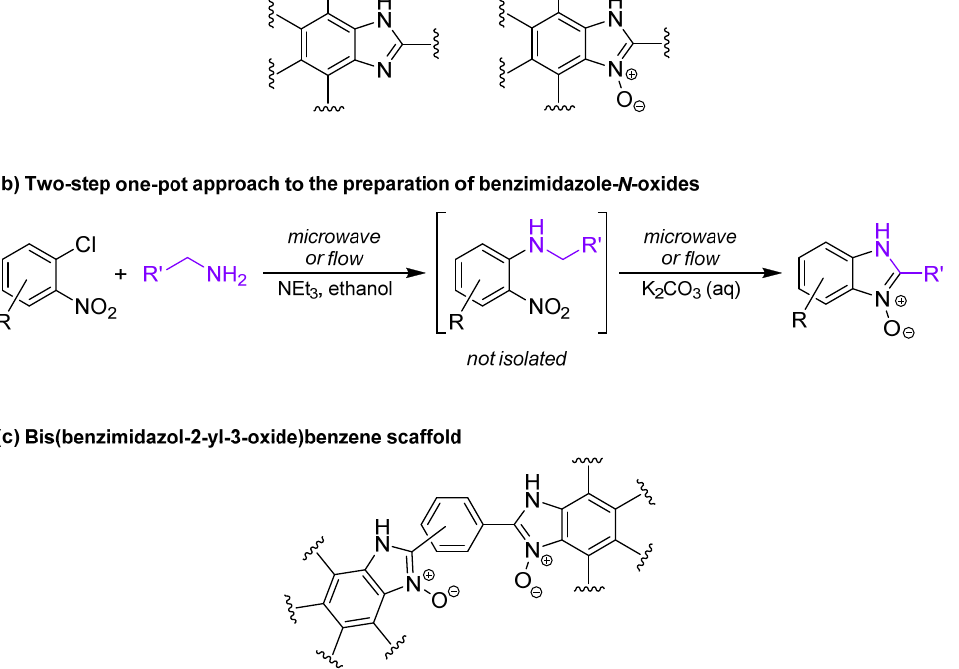
Figure 1. ( a ) The benzimidazole and benzimidazole- N -oxide scaffolds; ( b ) a two-step one-pot approach to the preparation of benzimidazole- N -oxides; ( c ) bis(benzimidazol-2-yl-3-oxide)benzene scaffold. 39